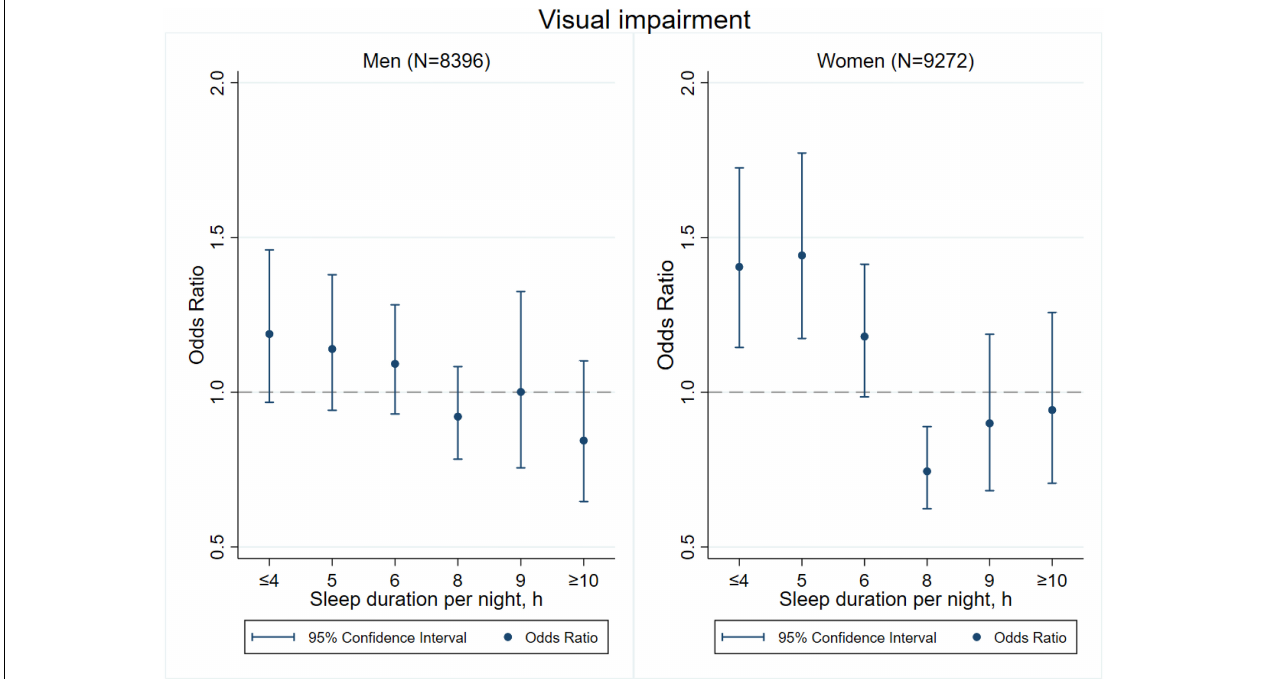
FIGURE 3 | Gender-specific effect of sleep duration on visual